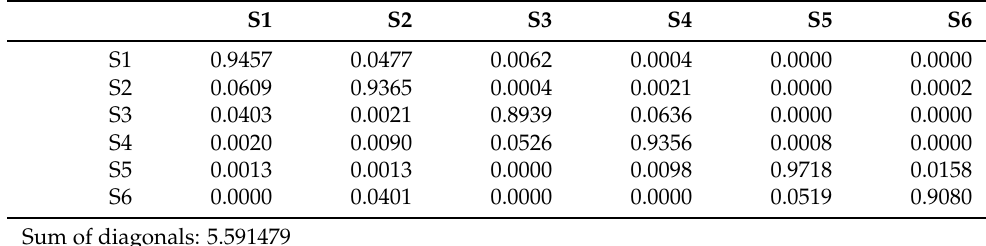
Table 1. Transition matrix of the benchmark clusters of the alanine dipeptide with S1–S6 shown in Figure